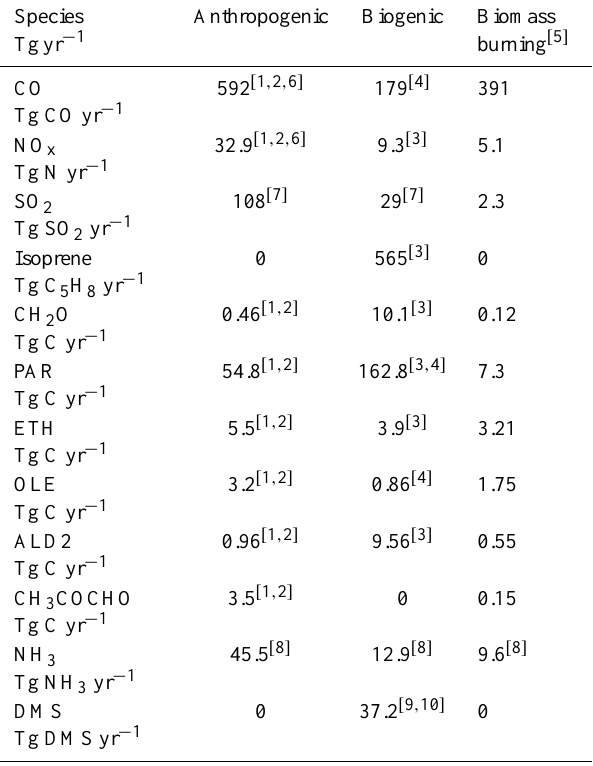
Table 6. Selected soil, water, snow/ice and mesophyl resistances according to Ganzeveld and Lelieveld (1995) and Ganzeveld et al. (1998), in sm − 1 . The cuticle resistance is 10 5 sm − 1 , for all trace gases except for HNO 3 and N 2 O 5 , where a value of 1sm − 1 is adopted.